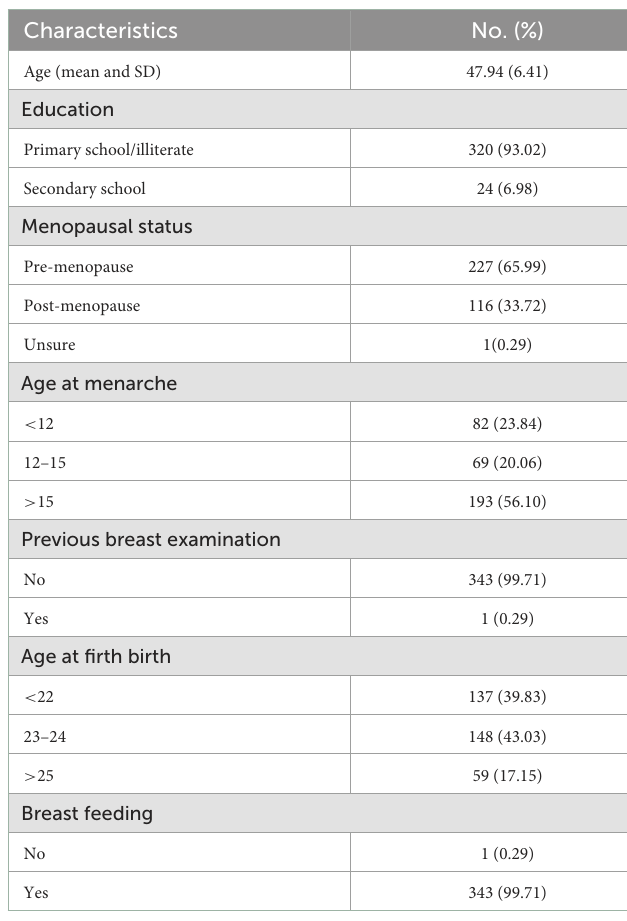
TABLE 1 Basic characteristics of the study